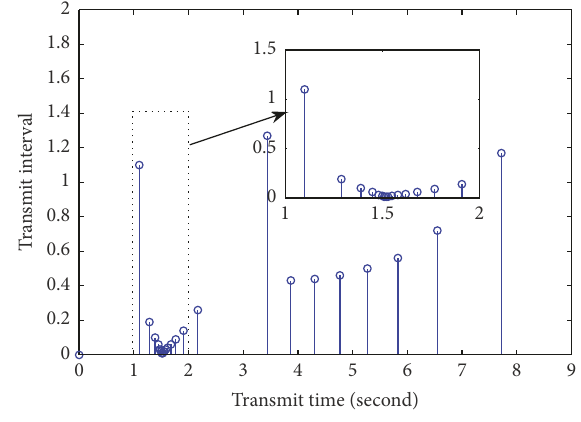
Figure 11: Release